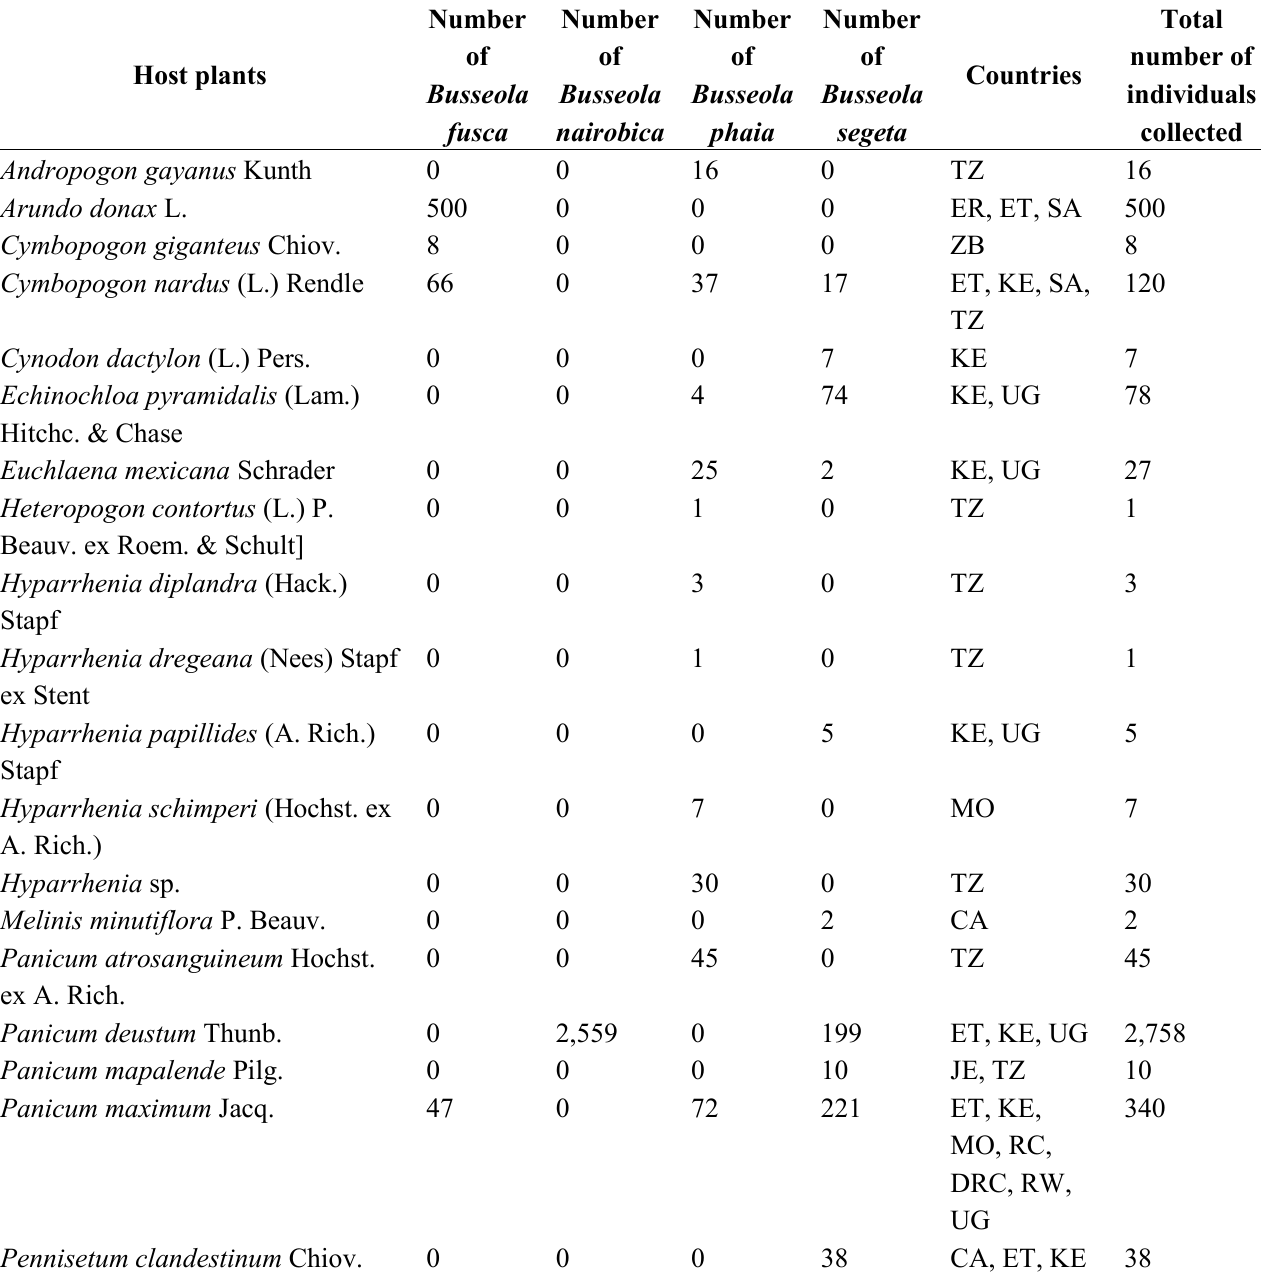
Table 1. A summary of Busseola spp. and their host plant identified during surveys in 15 countries, on 197 plant species belonging to Poeaceae, Cyperaceae, Typhaceae, Juncaceae and Thurniaceae families. Surveys were conducted between 2003–2013 in sub-Saharan Africa, following the sampling procedure described by Le Ru and colleagues [63] (total number of noctuid stem borer larvae collected was 48,910)